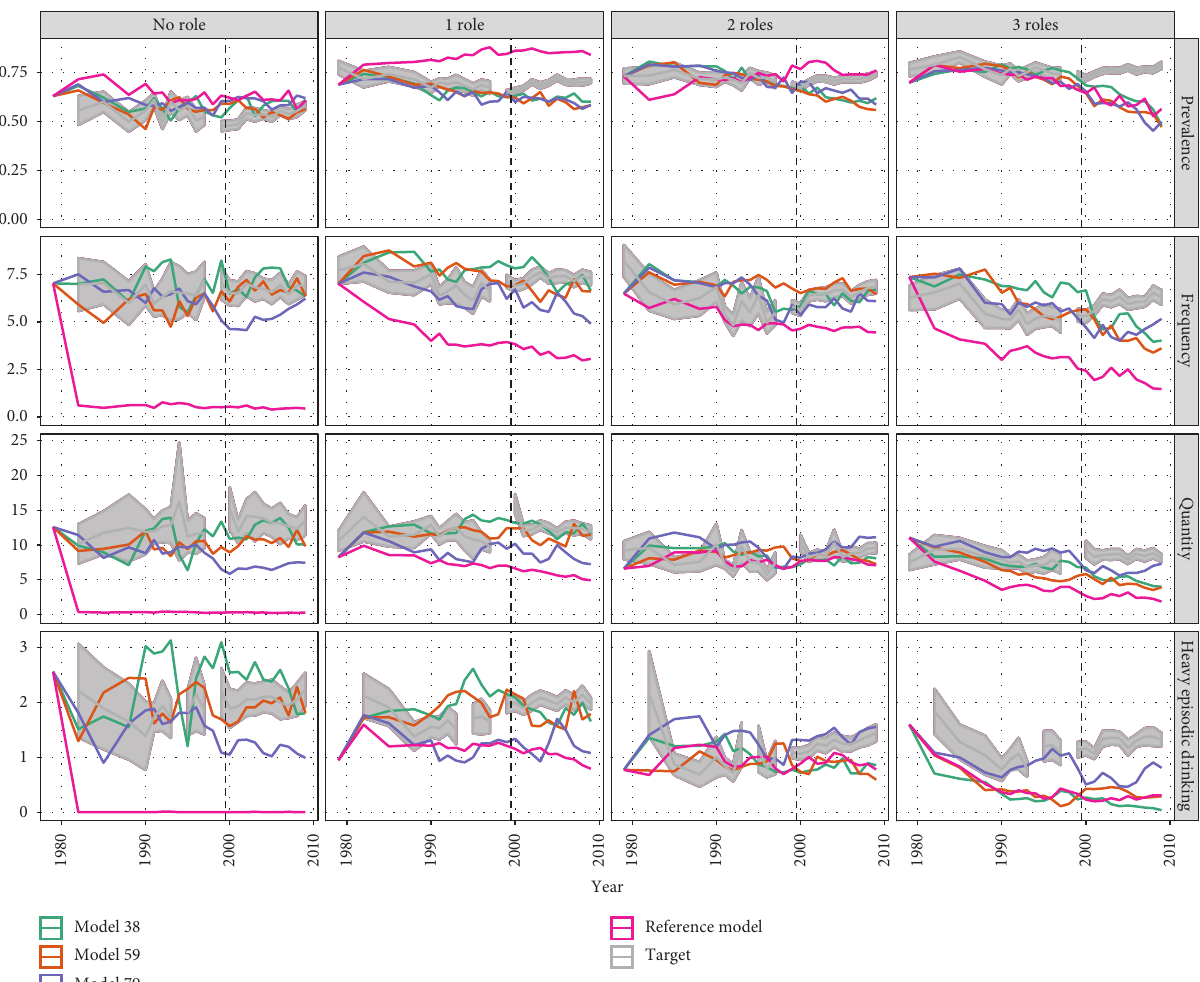
Figure 6: Time series of 16 outputs of the reference model, 3 credible GGP models, and the empirical target data (mean target data ± 95% confidence interval). The horizontal axis is the simulated years and each graph has a dashed vertical line that separates 20 calibration years and 10 validation years. The vertical axis is the value for each target with different units for prevalence (of current drinking in the past 12 months), frequency (average number of drinking days in the past 30 days among current drinkers), quantity (average grams of pure alcohol consumed per day among current drinkers in the past 30 days), and heavy episodic drinking (average number of days where 5+ drinks were consumed in the past 30 days among current